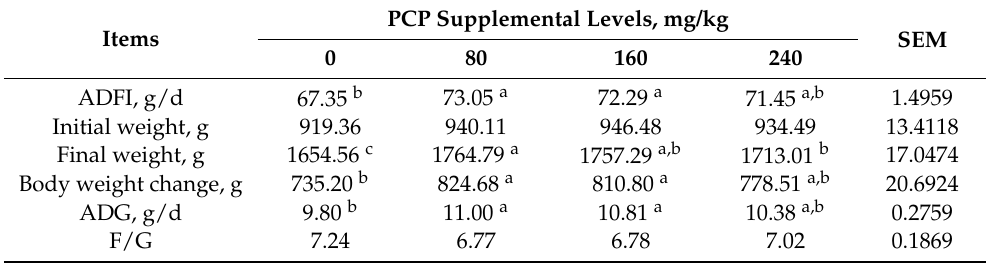
Table 2. Effect of anthocyanin-rich PCP on growth performance of growing chickens.